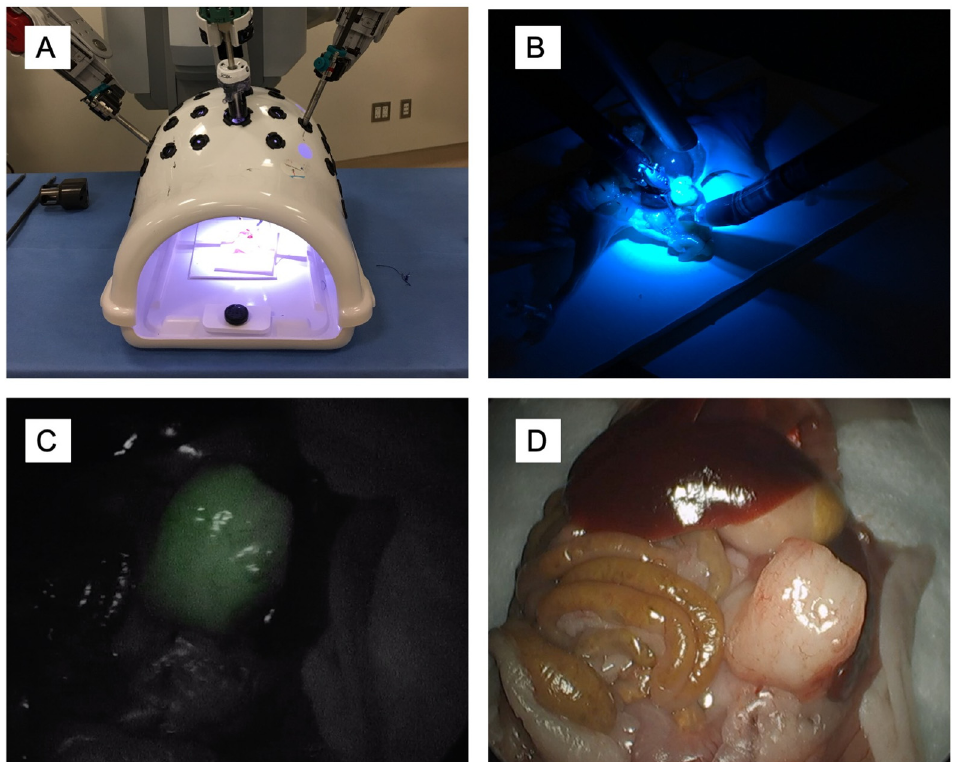
Figure 1. Fluorescence signal is detectable at the tumor using an anti-CEA nanobody conjugated to IRDye800CW using clinically available FDA-cleared fluorescence imaging devices. Images were acquired after placing the animal within the minimally-invasive simulation dome ( a ) and switching between the bright light and the fluorescence mode ( b ). Representative images from fluorescence imaging using the Stryker Aim laparoscopic camera (Kalamazoo, MI, USA) and the corresponding bright light image ( c , d ). Tumors are approximately 7 mm–1 cm at the time of imaging.